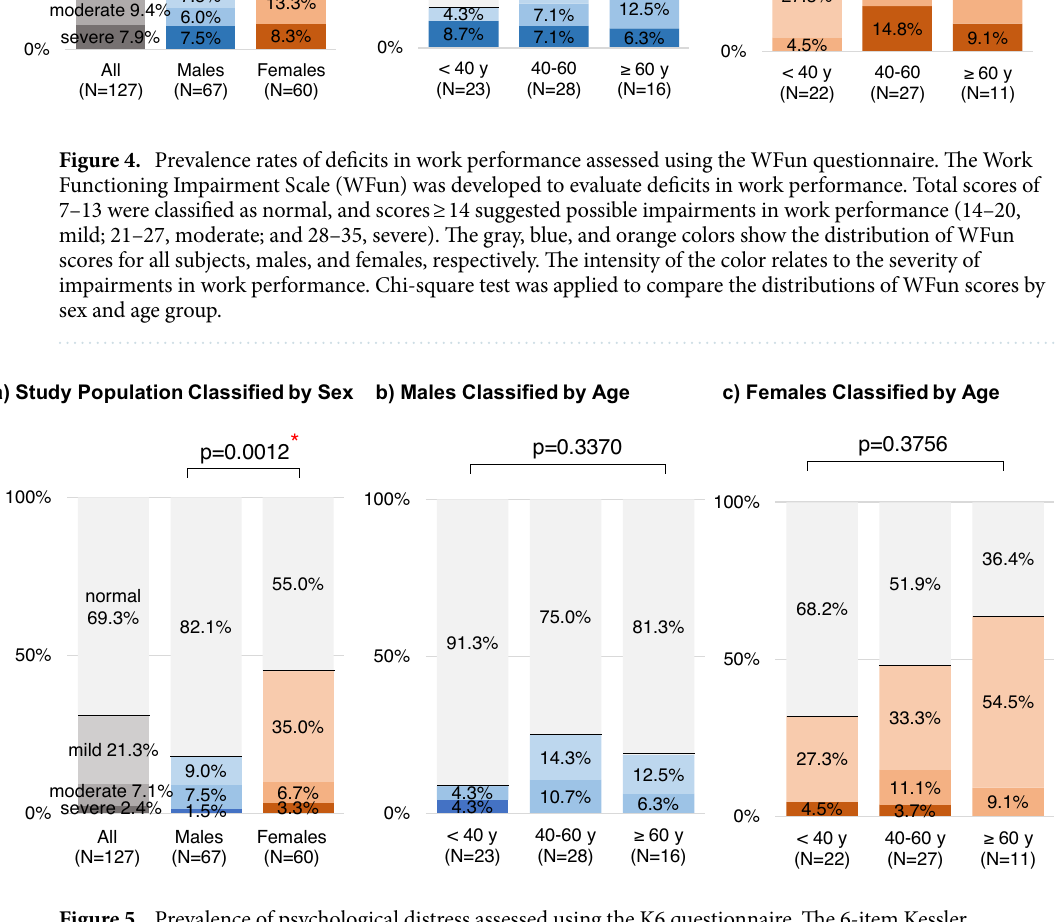
Figure 5. Prevalence of psychological distress assessed using the K6 questionnaire. The 6-item Kessler Psychological Distress Scale (K6) was developed to screen for mood and anxiety disorders. Total scores of 0–4 were classified as normal, and scores ≥ 5 suggested possible mood and anxiety disorders (5–9, mild; 10–14, moderate; and 15–24, severe). The gray, blue, and orange colors show the distribution of K6 scores for all subjects, males, and females, respectively. The intensity of the color relates to the severity of psychological distress. Chi-square test was applied to compare the distributions of K6 scores by sex and age group. Asterisk (*) indicates statistically significant difference (p < and neurological systems. Possible mechanisms underlying long COVID may include immunologic aberrations and inflammatory damage in response to the acute infection, as well as virus-specific pathophysiologic changes 14 . ACE2, the major cell entry receptor for SARS-CoV-2, is extensively expressed in numerous human tissues and organs. Respiratory and other sequelae of long COVID have been found to be common in organs with high ACE2 expression 27,28 . In our study, patients aged ≥ 60 years were more likely than other age groups to report fatigue, palpitations, dry eye or mouth, dyspnea, and sputum production, whereas patients aged < 40 years reported lower prevalence rates of all sequelae except for olfactory and taste disorders. Indeed, the fact that olfactory and